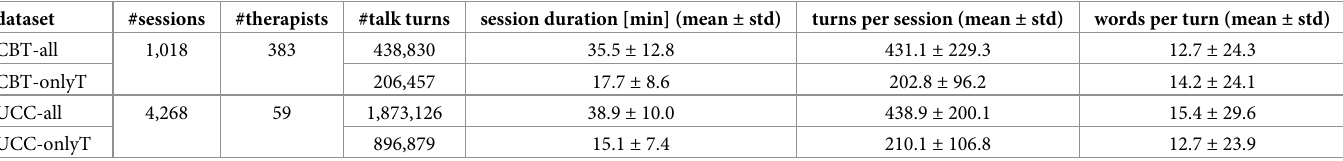
Table 3. Size of the datasets used to train and evaluate the proposed